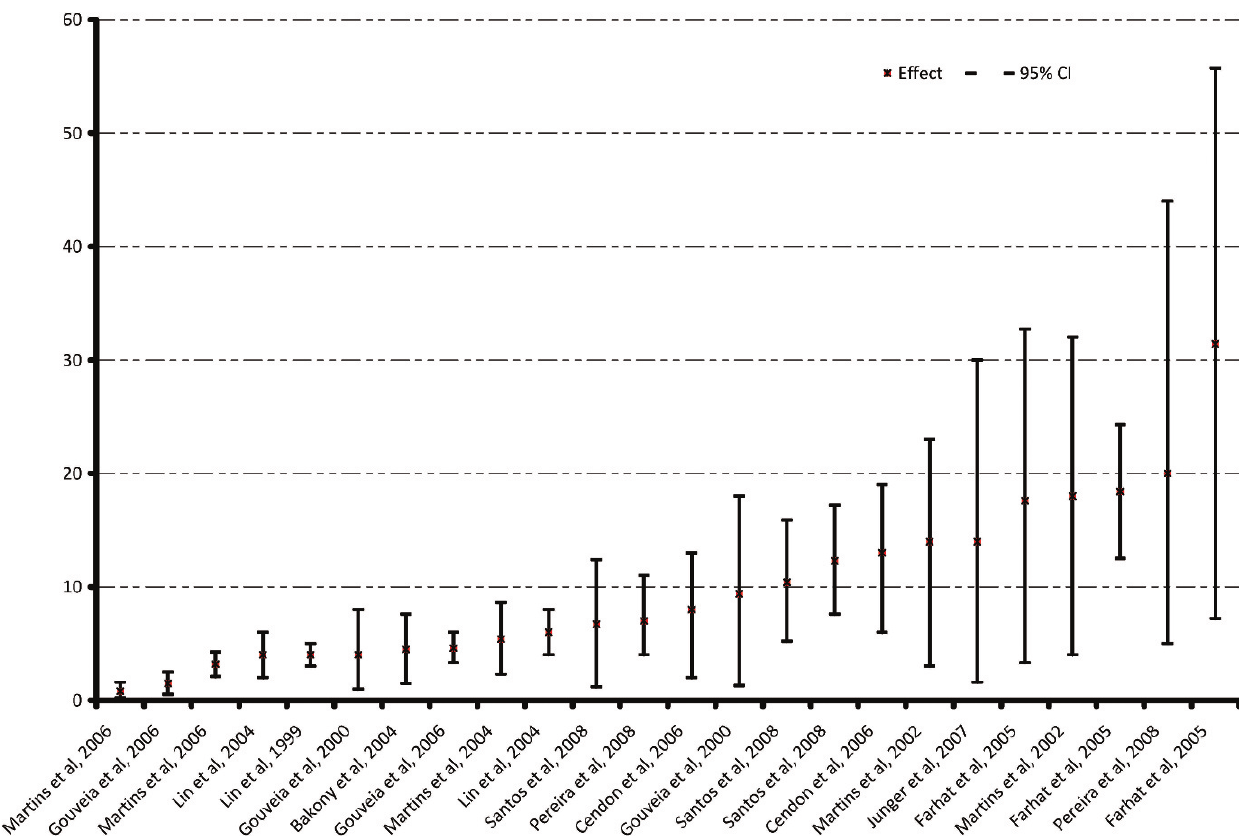
Figure 3 - Percentage increase interval (CI 95%) from Brazilian studies of air pollution and adverse human